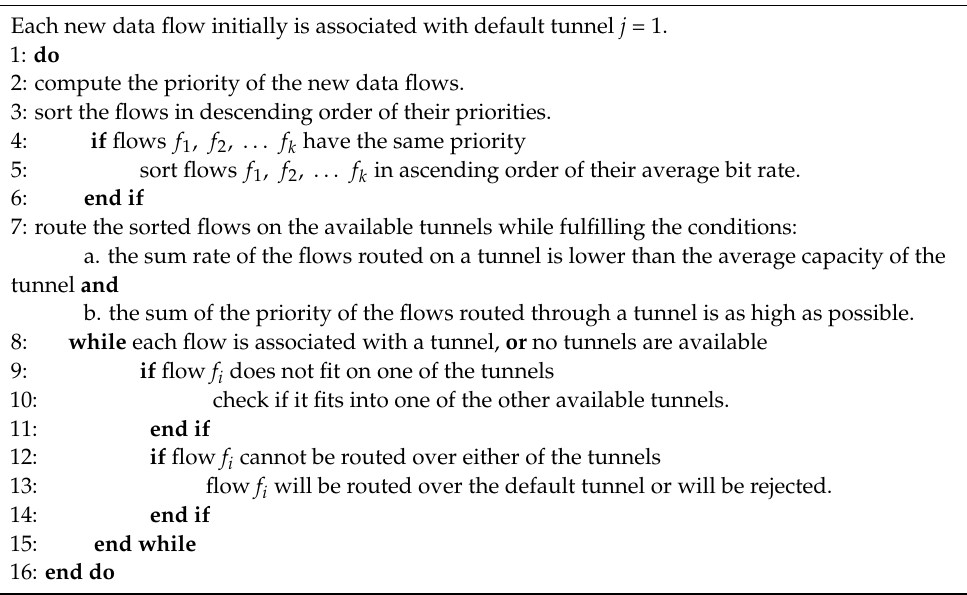
Algorithm 5 Multiple Knapsack load-balancing